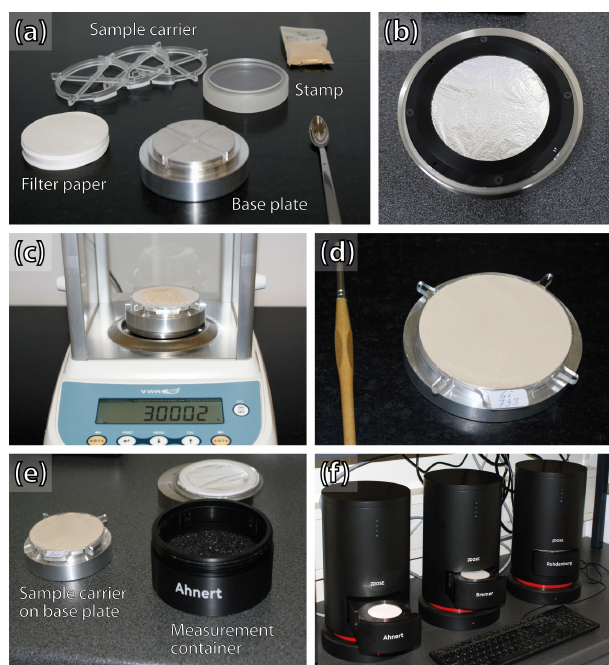
Figure 1. Photos showing the µ Dose devices and equipment: (a) sample carrier and equipment for sample preparation. (b) Scin- tillator unit with silver foil. (c) High-precision balance used for weighing 3 . 00g of sample material. (d) Prepared sample on a sam- ple carrier with a diameter of 70mm. (e) Prepared sample material and measurement container. (f) Three µ Dose devices installed in the Giessen Luminescence Laboratory.